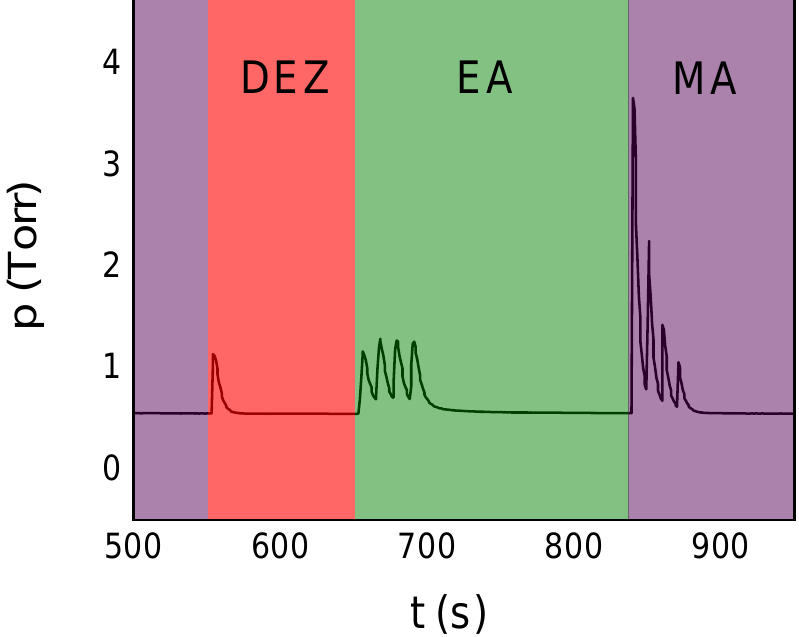
Figure 8. Pressure values as read during the precursor pulses in a typical ABC recipe.